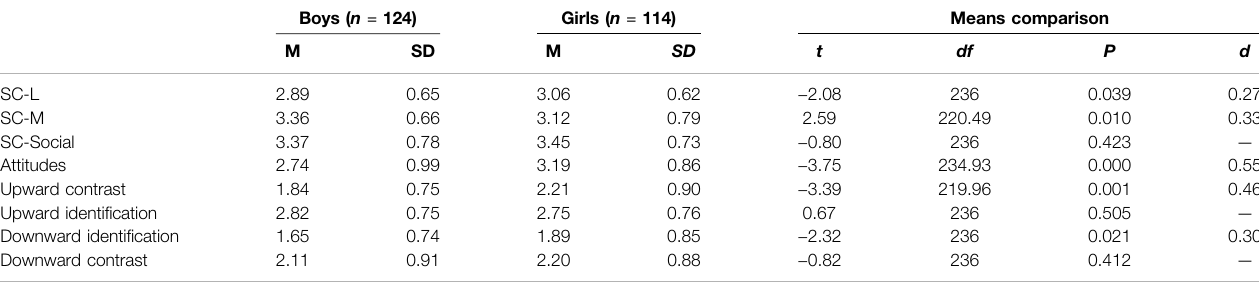
TABLE 1 | Means (M), standard deviations (SD) and t -test results for gender differences.